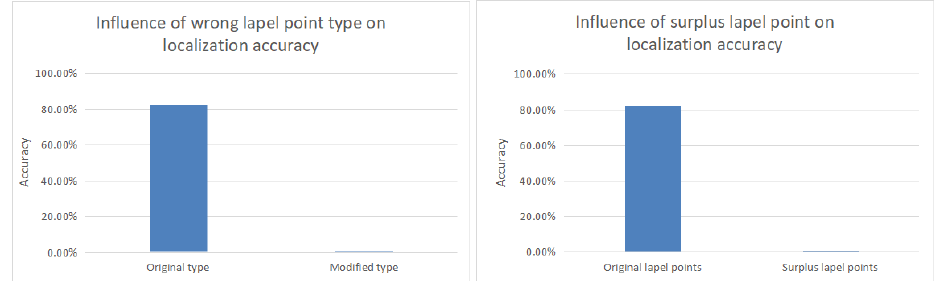
Figure 43. The influence of incorrect lapel points: ( Left ) Influence of incorrect lapel point type on localization accuracy; and ( Right ) influence of surplus lapel points on localization